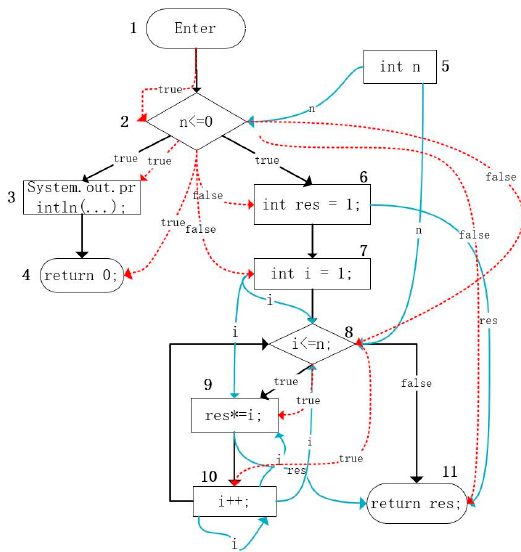
Figure 3. Program dependency graph.